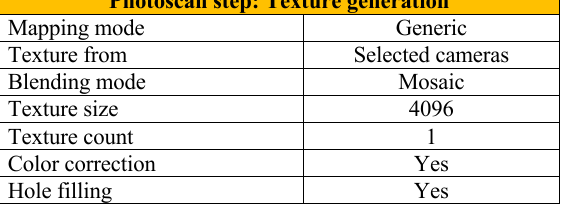
Table 8. Texture generation settings.